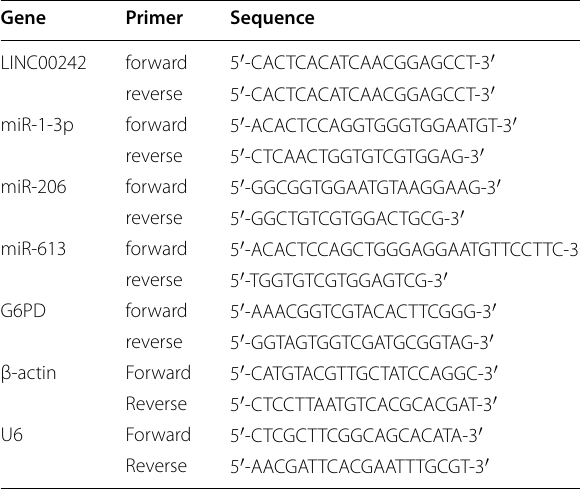
Table 3 Primer sequence for qRT-PCR